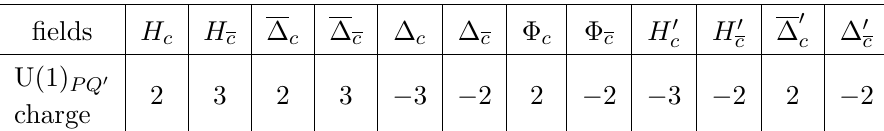
Table 2 . U(1) PQ 0 charges of the color-triplets with PQ 0 = (5 PQ and (cid:1) 0 multiplets, there is an associated isospin-doublet partner originating from the same Higgs c (cid:12)eld and carrying identical U(1) PQ 0 charge as that of the color-triplet. From these, we (cid:12)nd that the 54